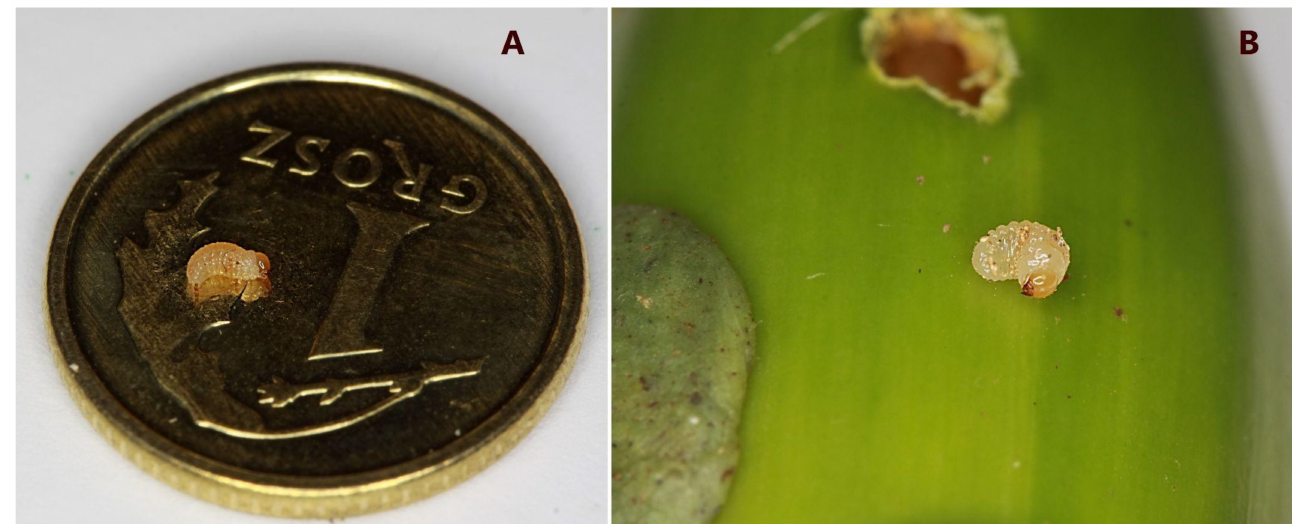
Figure 1. Larvae of the second instar with light brown head capsule, which indicates that the individual is newly molted: ( A )—larva on a coin of 15.5 mm diameter; ( B )—larva next to the prepared infestation hole.